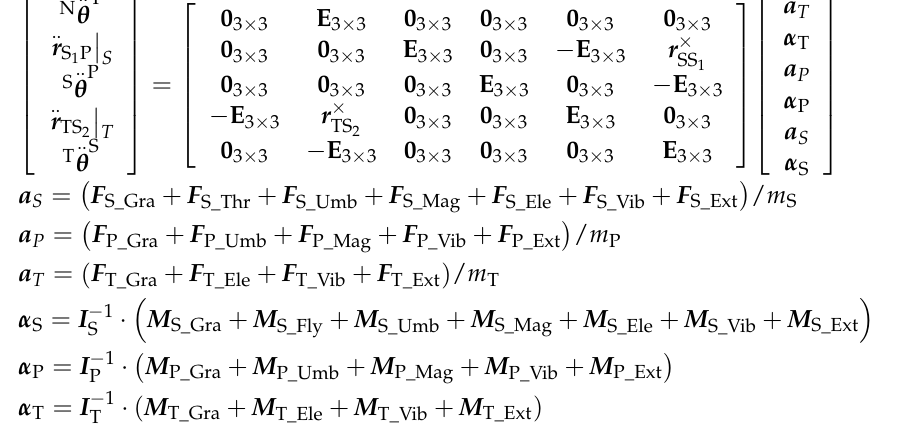
Figure 3. Control scheme of the improved DFP spacecraft.